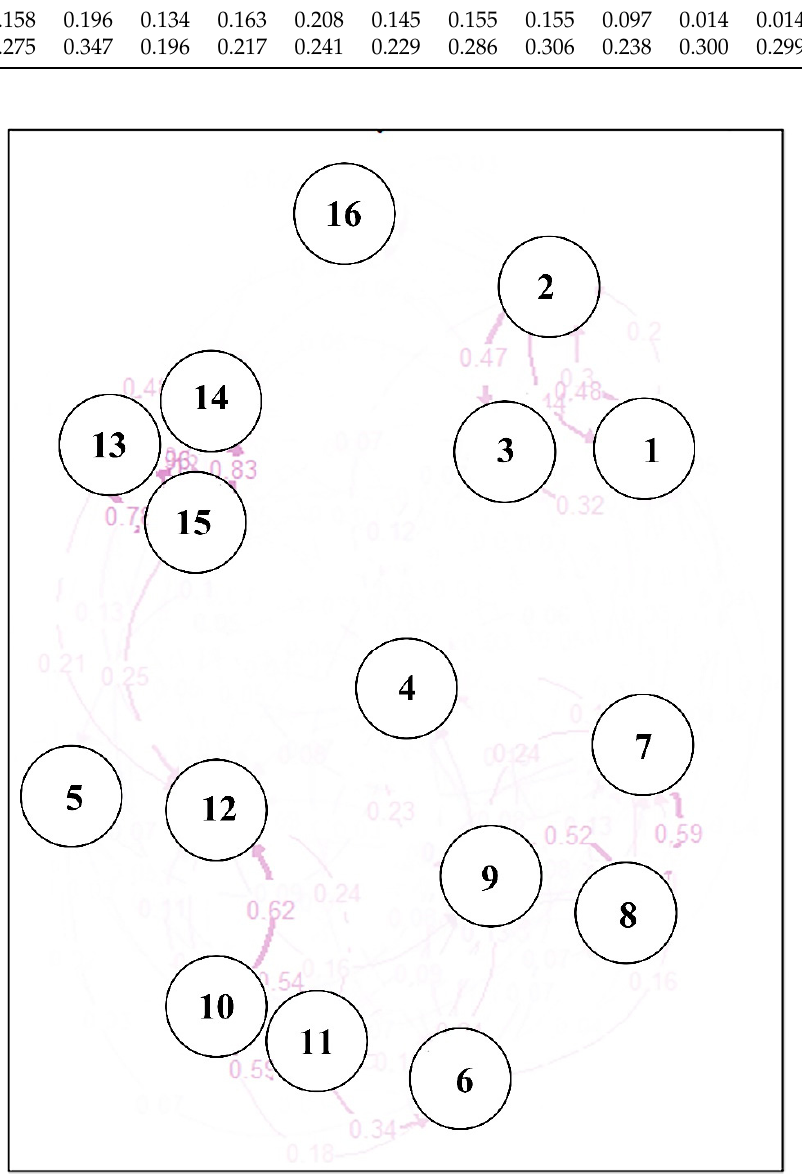
Figure 1. The relative migration network of 16 populations generated via divMigrates. The width of the line and the number shown next to the arrows indicate the migration rate. Table 4. Pairwise genetic differentiation index values (below the diagonal) and Nei’s genetic distance values (above the diagonal). **** indicates the diagonal division of the pairwise genetic differentiation index values and Nei’s genetic dis- tance values.